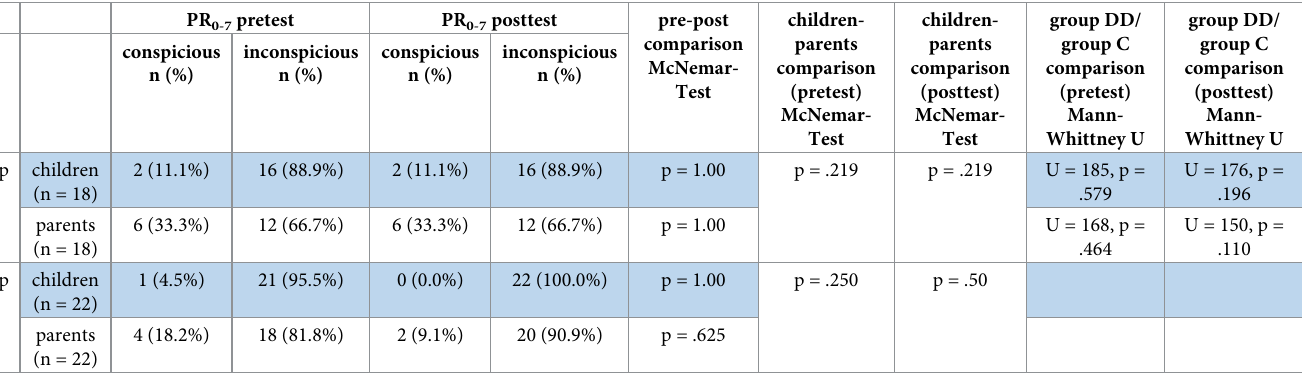
Table 4. Statistical data of problem score PR 0-7